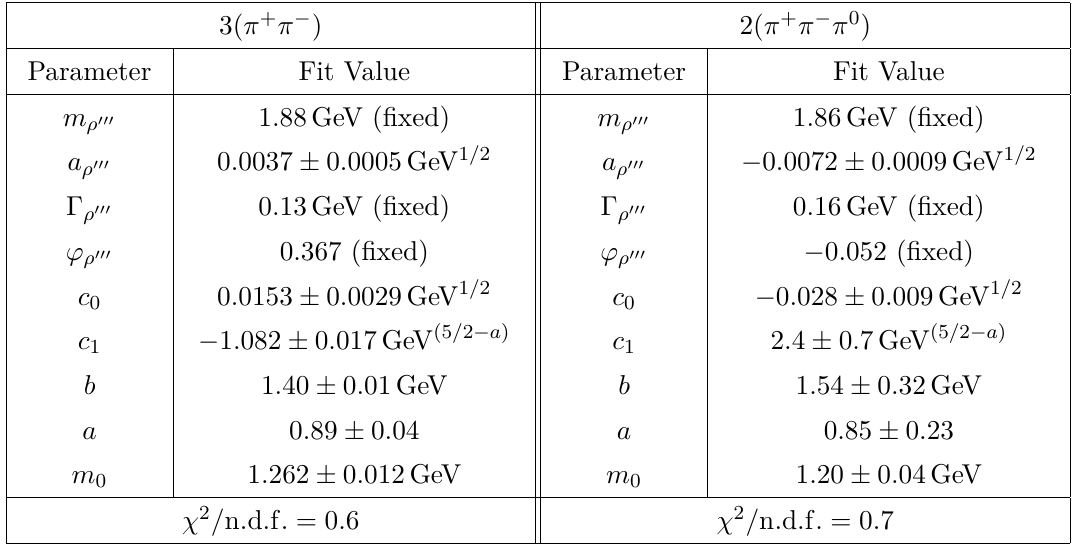
, Γ and ϕ were taken from ρ 000 ρ 000 ρ 000